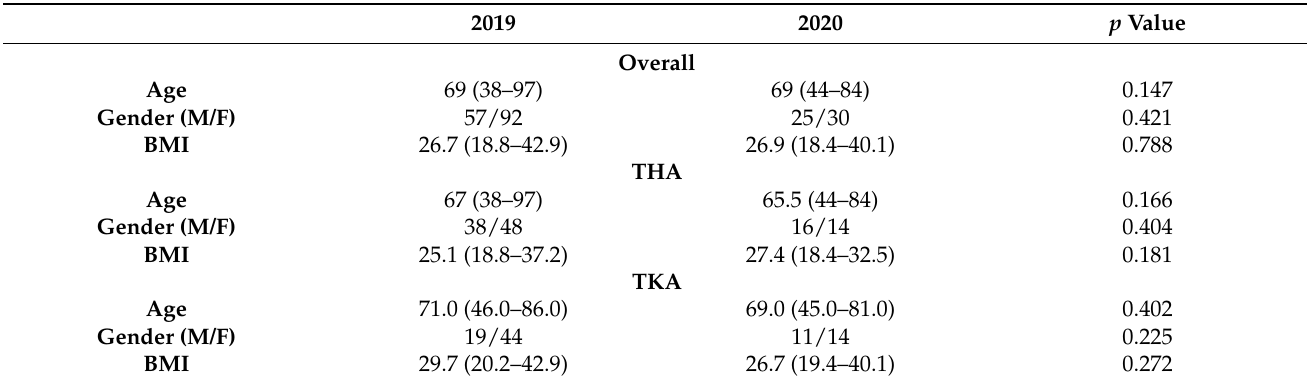
Table 1. Patients’ Demographics.